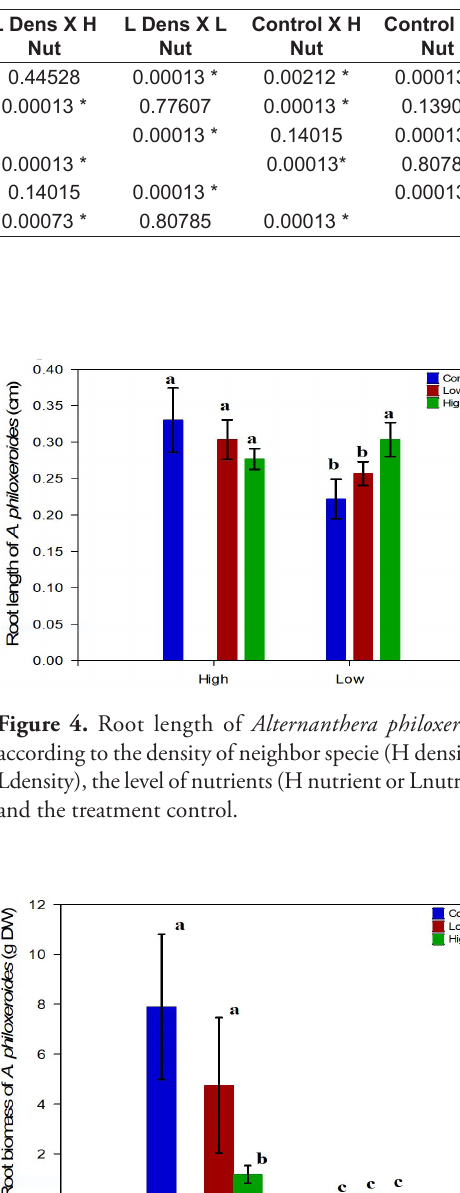
Table 2. Results of Tukey test carried a posteriori of ANOVA two way to verify the difference of density of P. ferrugineum and nutrient on shoot length of A. philoxeroides .